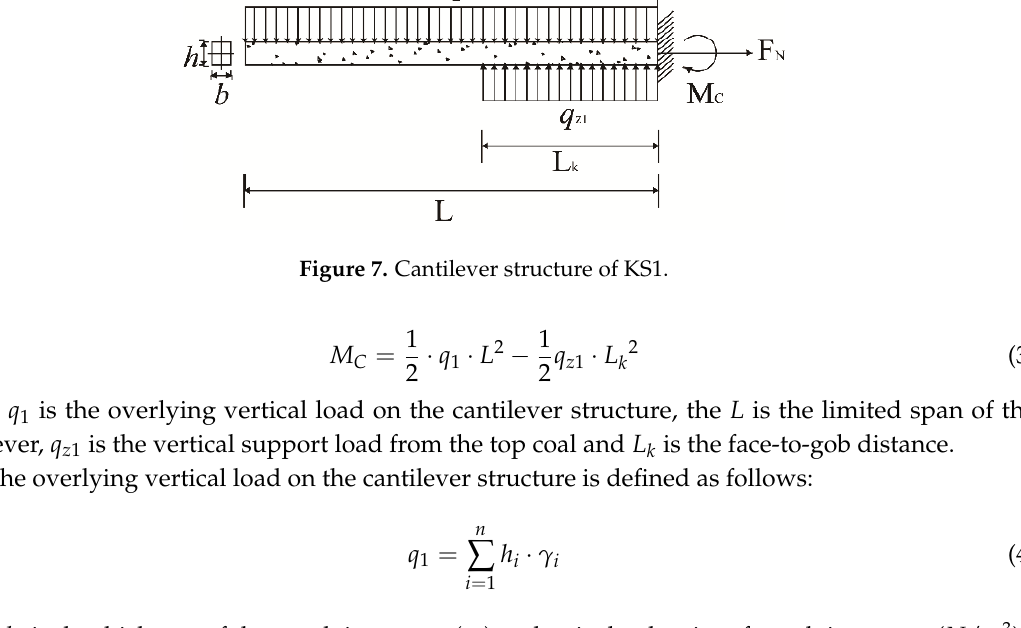
Figure 7. Cantilever structure of KS1.